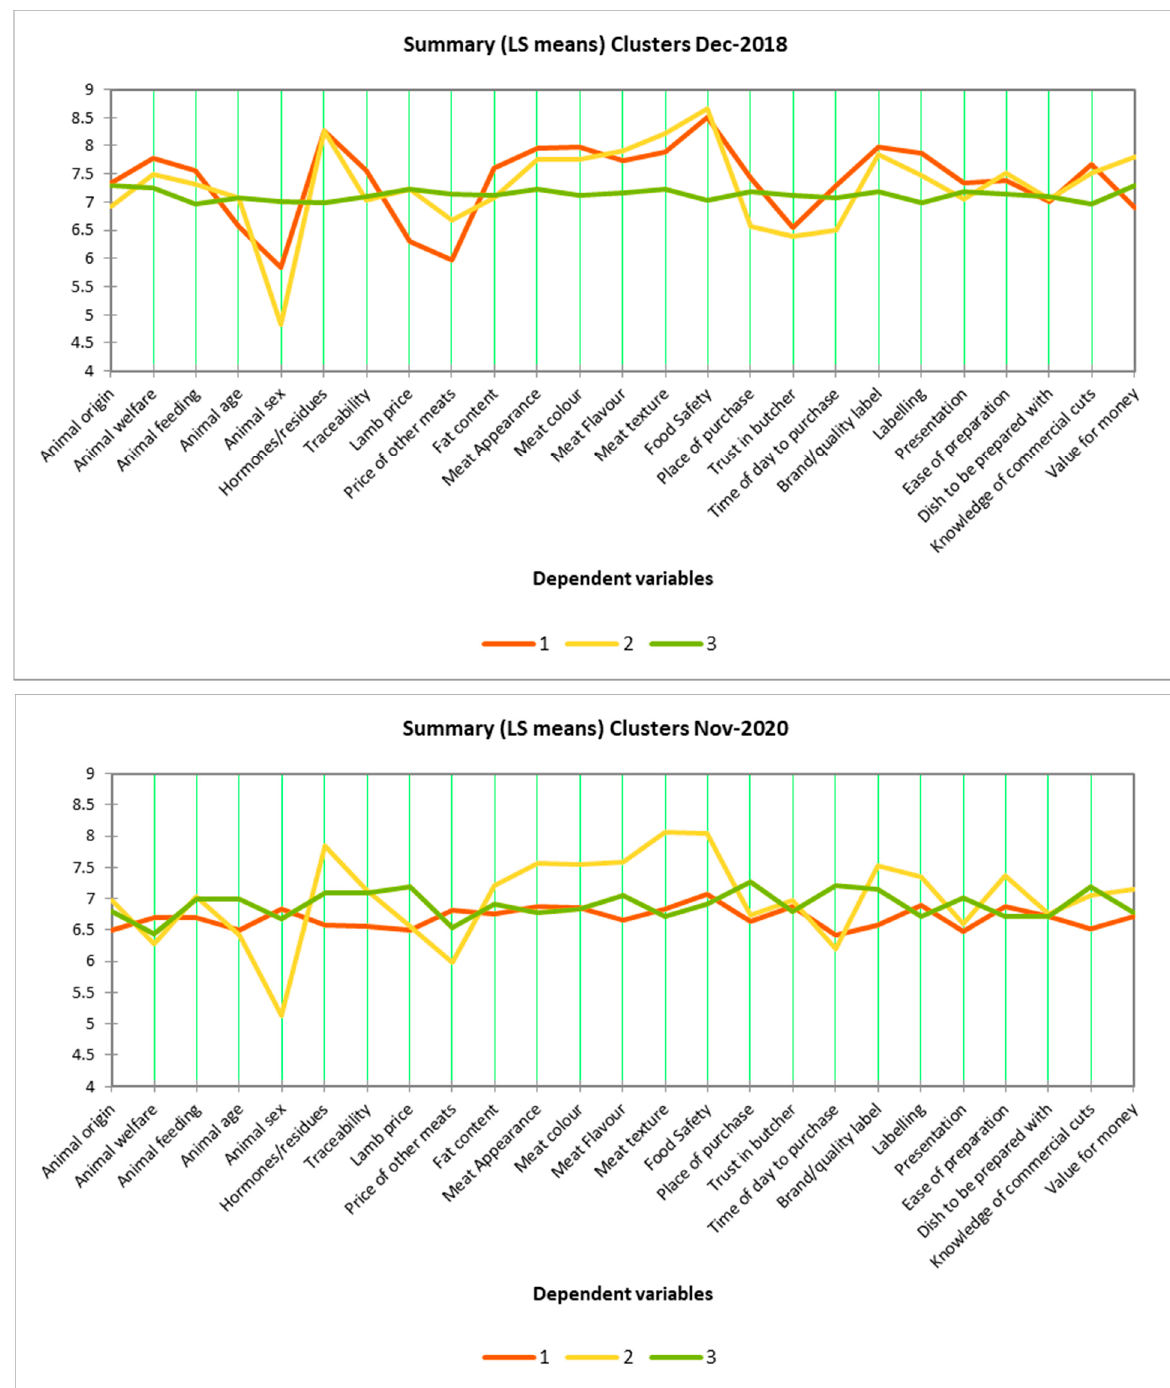
Figure 1. Cluster analysis of the importance ratings of lamb attributes at the point of purchase.